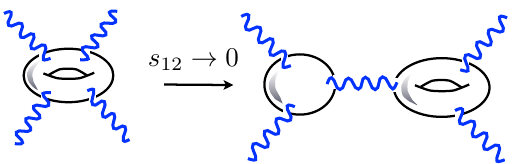
Figure 1 . Factorization onto (tree-level 3-point)